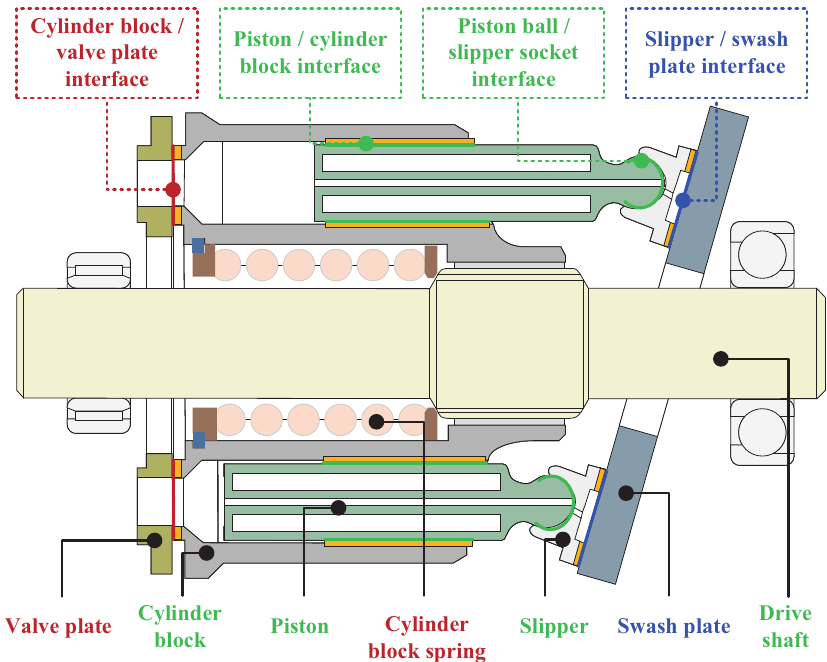
Figure 1. Structure of the